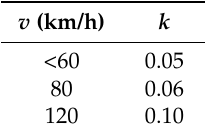
Table 1. k coefficient relating the luminance needed in the threshold (L th ) with the L20 luminance (From CIE 88:2004, 2004, [1]).